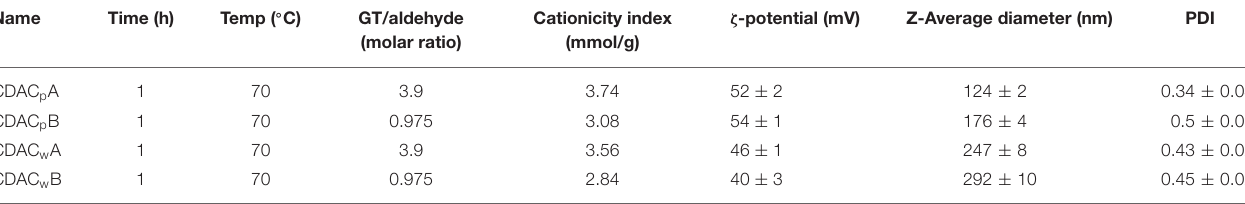
TABLE 1 | Cationization reaction conditions used for synthesis of cationic bio-PELs and characterization of final products.